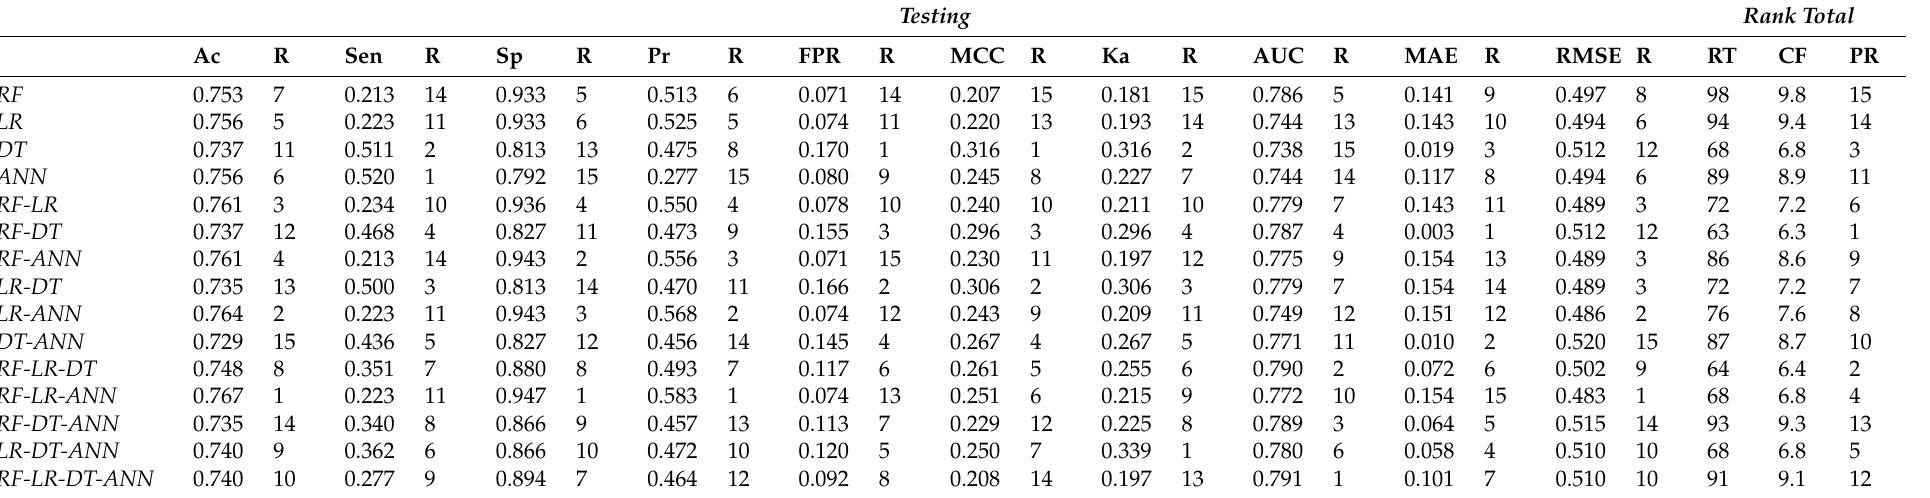
Table 6. Results of validation techniques and accuracy prioritization based on testing